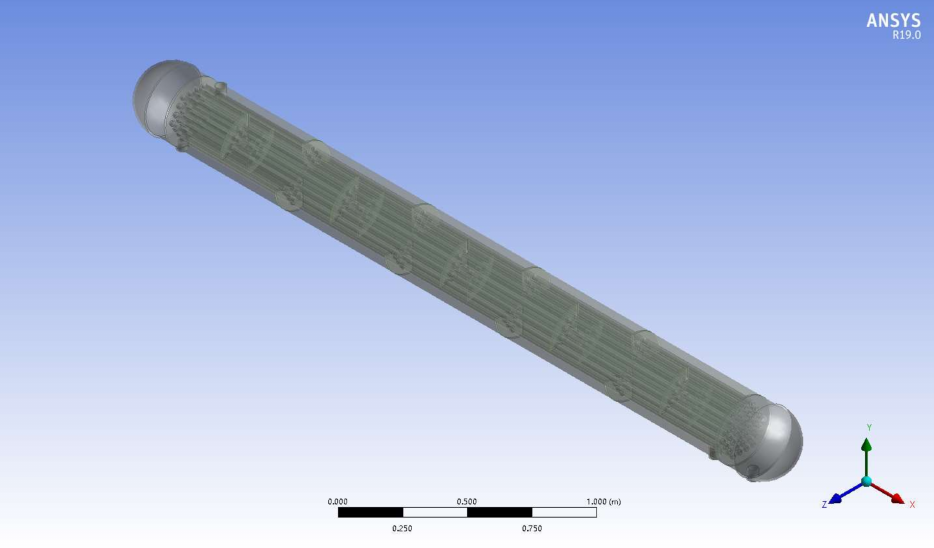
Figure 4. Three-dimensional model of shell-and-tube heat